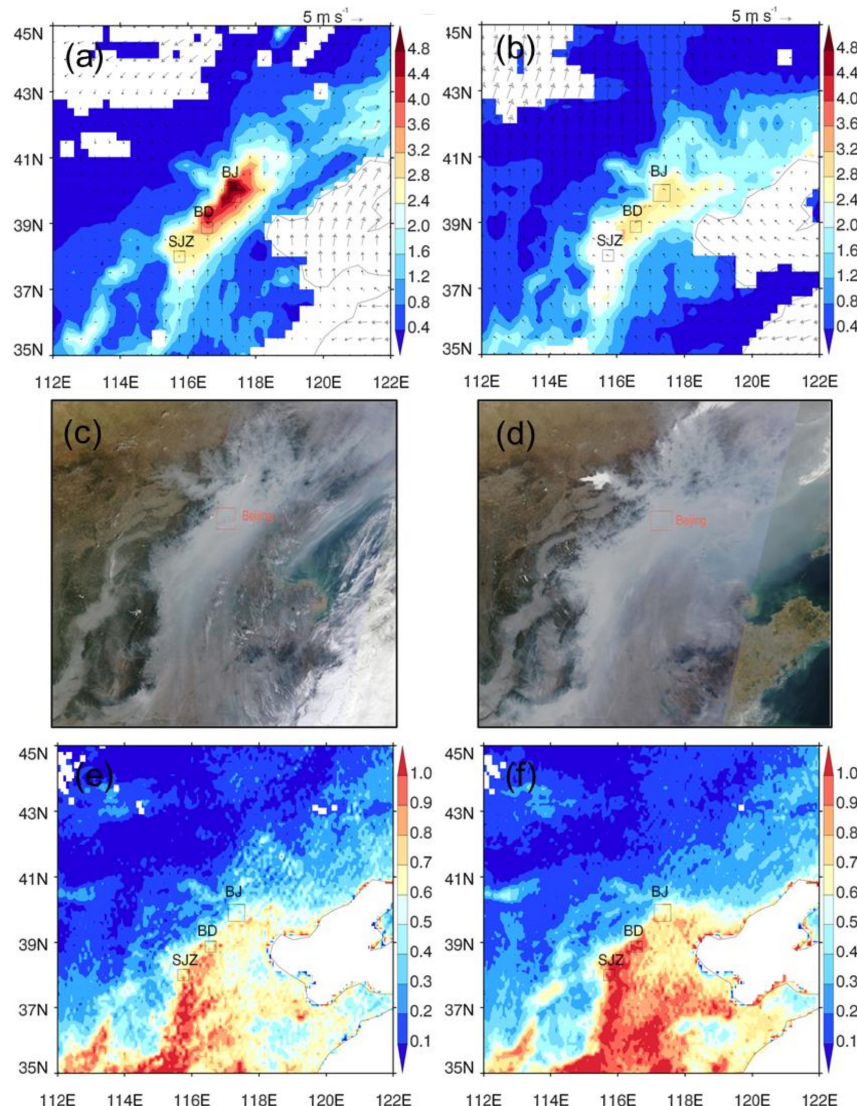
Figure 2. MODIS AOD (a, b) and visible images (c, d) illustrating the two severe haze episodes in Fig. 1. Panels (a) and (c) correspond to 28 September, 2013, and (b) and (d) correspond to 5 October 2013. Panels (e) and (f) represent MODIS AOD of fall seasonal and annual mean in 2013. The megacities of Beijing (BJ), Baoding (BD), and Shijiazhuang (SJZ) are marked as squares. Wind field imposed on (a) and (b) is based on ECMWF reanalysis